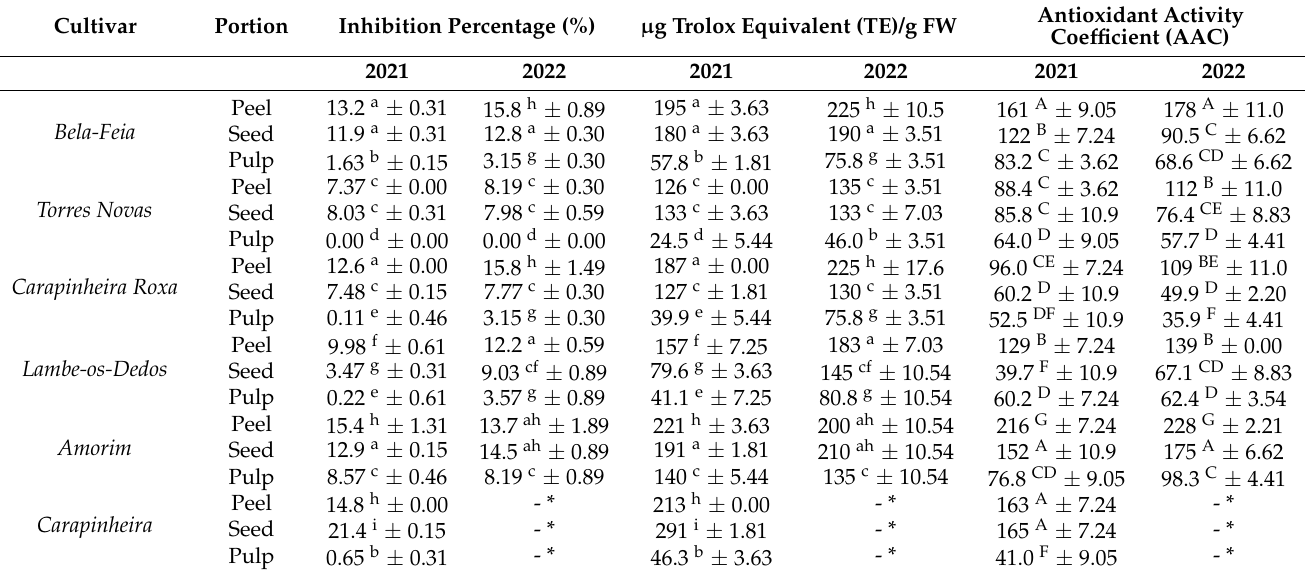
Table 3. Antioxidant capacity of different portions of pear cultivars using two methods: DPPH radical scavenging assay and the β -carotene bleaching assay. Results are expressed in means ± standard